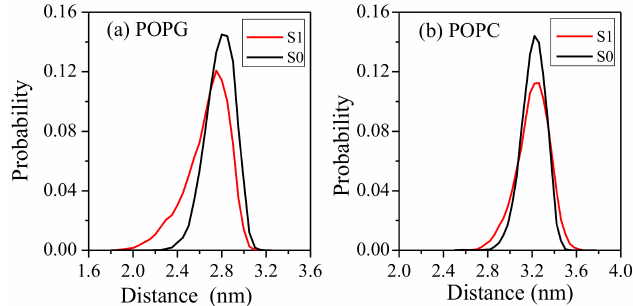
Figure 6. Distribution of the z-component of the minimum distance between the phosphate atoms of the two leaflets during the last 100 ns simulations. S0 and S1 denote the simulations of the membrane without and with LL-37 for ( a ) POPG bilayer and ( b ) POPC bilayer, respectively.